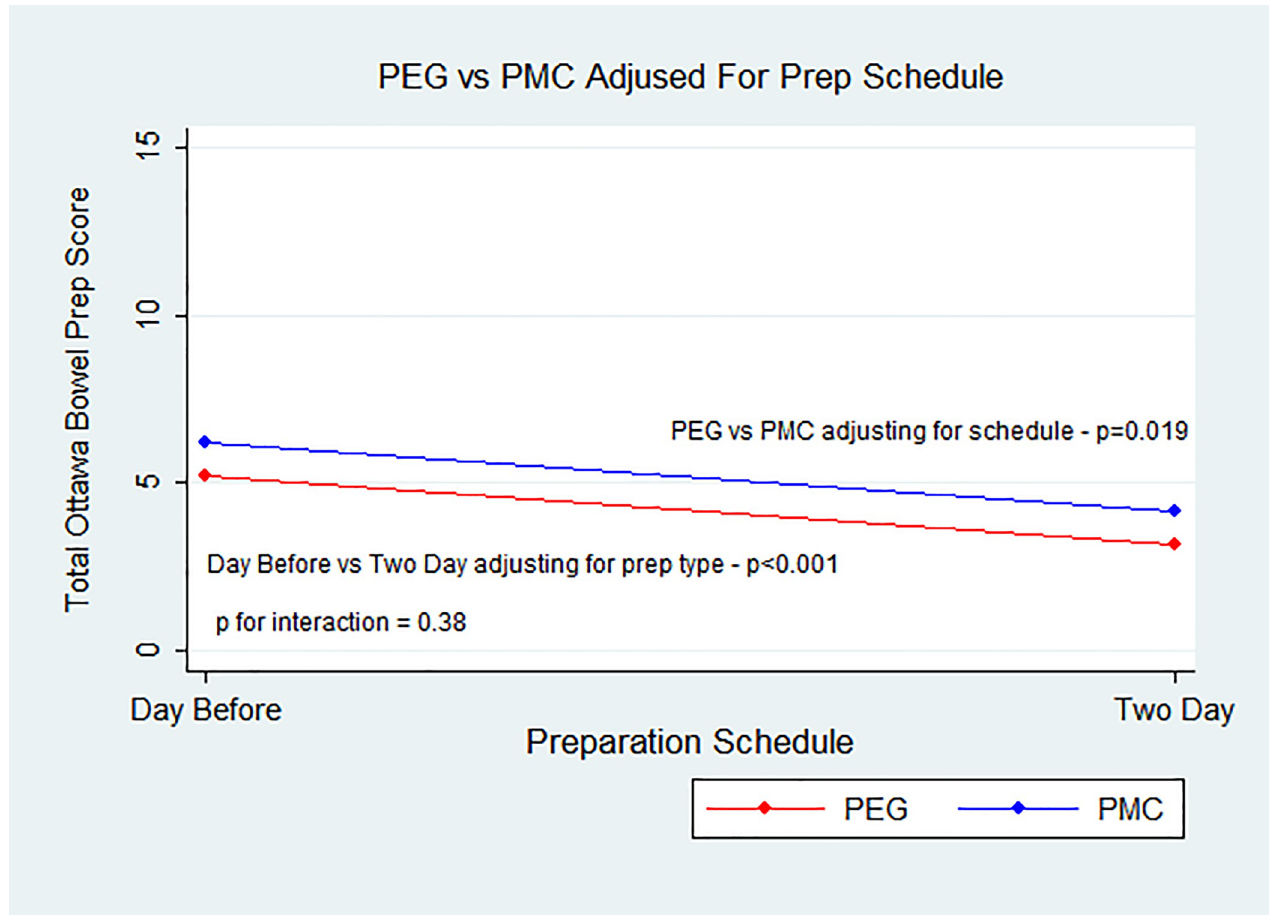
Fig 2. Mean OBPS for PMC and PEG, adjusting for timing of administration. PEG is superior with a lower mean score of 4.14 ± 2.64 compared to PMC, which has a mean score of 5.11 ± 3.44 (P = 0.019).